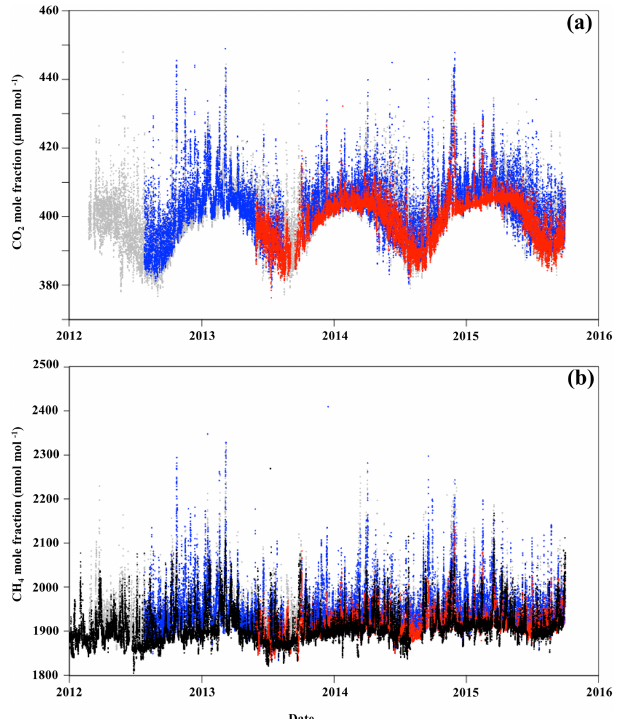
Figure 7. Time series of (a) N 2 O and (b) SF 6 mole fractions at MHD (black; 10m inlet), RGL (grey; 90m inlet) and TAC (blue; 100m inlet) from 1 January 2012 to 30 September 2015. All results shown are hourly averages. N 2 O results are shown in nmolmol − 1 and are on the SIO-98 scale, whilst SF 6 results are shown inpmolmol − 1 and are on SIO-05 scale. SF 6 results from MHD are made using the Medusa